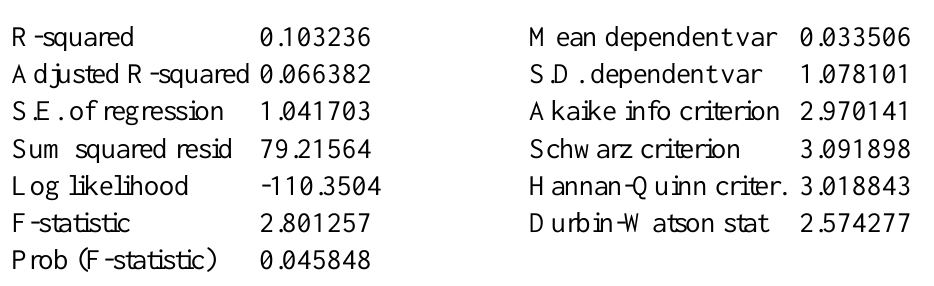
Table 7 Determination Coefficient Test